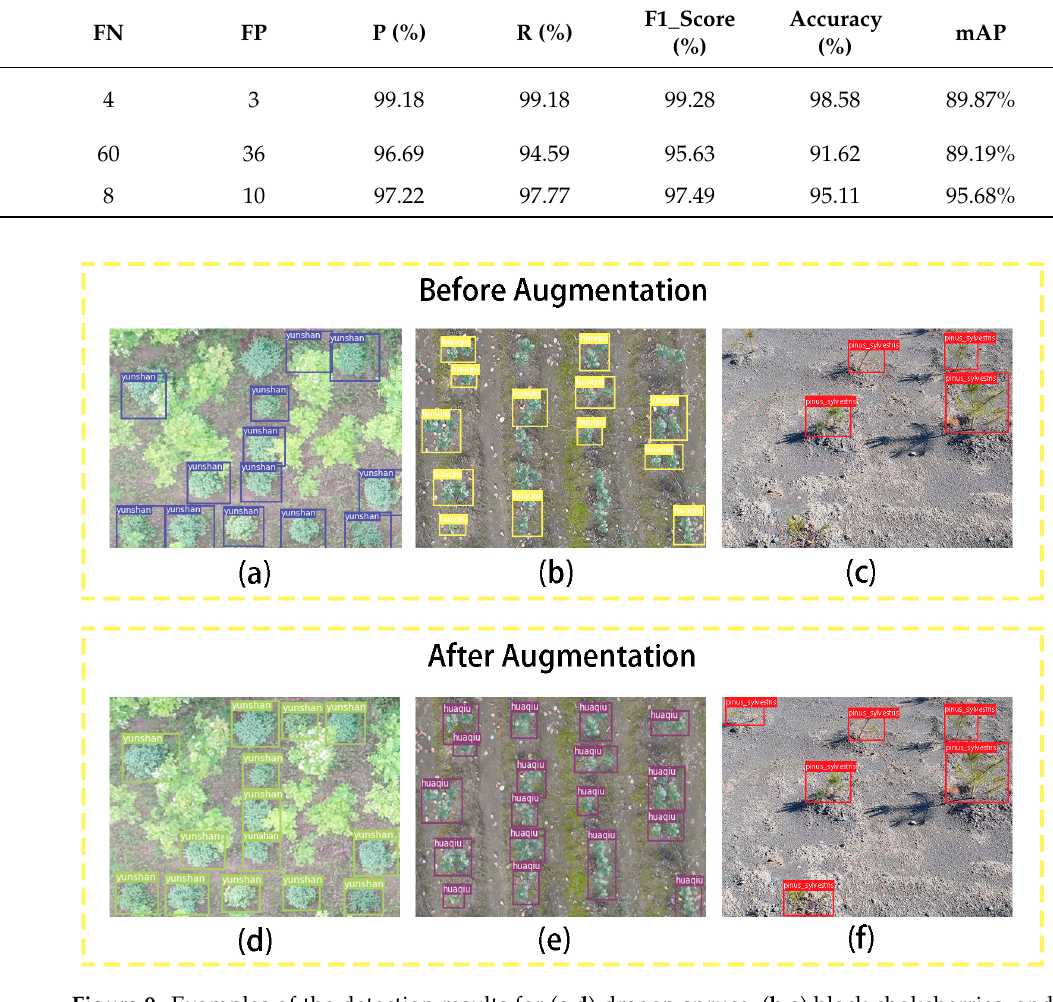
Figure 9. Examples of the detection results for ( a , d ) dragon spruce, ( b , e ) black chokeberries, and ( c , f ) Scots pine.